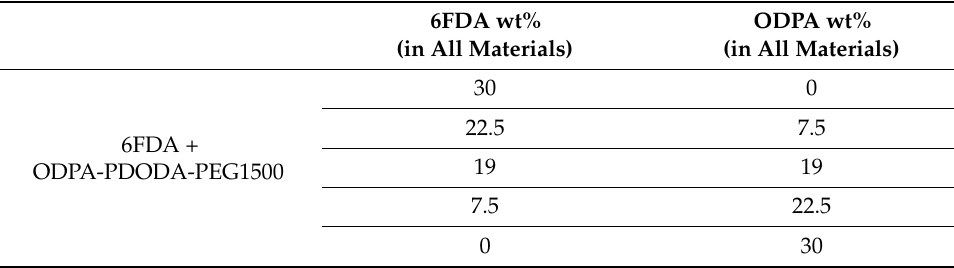
Table 2. SBC membrane systems with varying wt% of